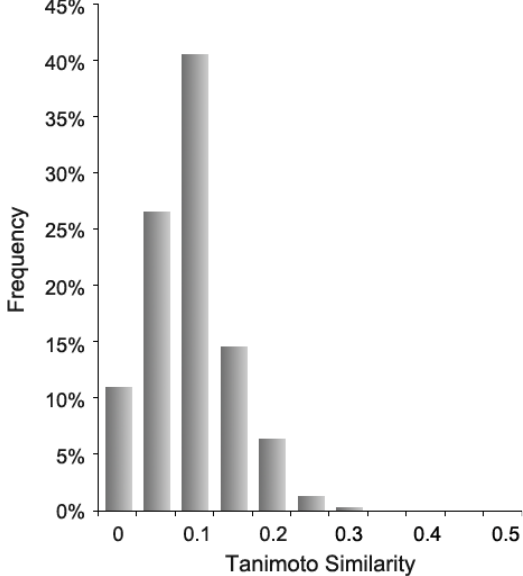
Figure 2. Distribution of similarities between 5 million drug-like, commercially available compounds and the most similar